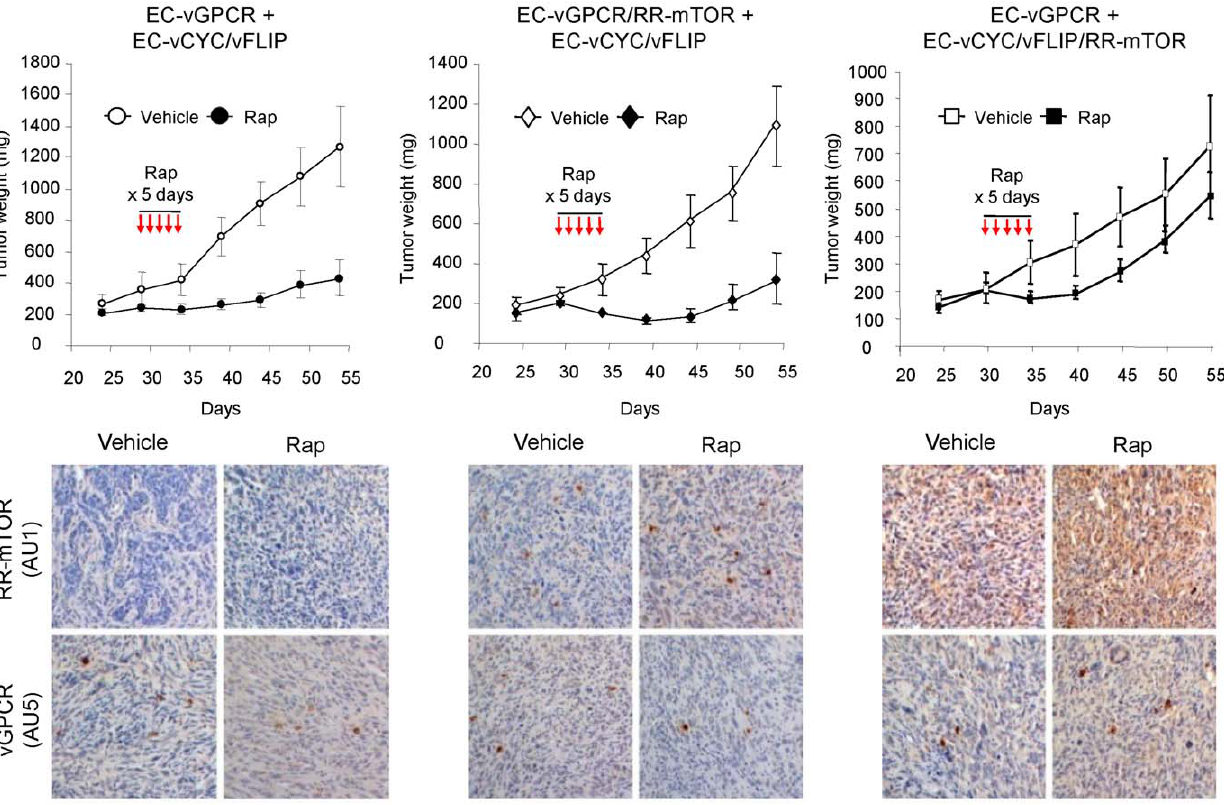
Figure 4. Paracrine activation of mTOR is required for vGPCR sarcomagenesis invivo . Tumor allografts were generated upon injection of athymic nu/nu mice with EC-vGPCR (10%) + EC-vCYC/vFLIP (90%) cells, EC-vGPCR/RR-mTOR (10%) + EC-vCYC/vFLIP (90%) cells or EC-vGPCR (10%) + EC-vCYC/vFLIP/RR-mTOR (90%) cells. Lesions were then treated with (10 mg/kg) Rapamycin or vehicle. Curves of tumor growth and immunohistochemical staining of tumor tissue with anti-AU1 or anti-AU5 antibodies, revealing expression of RR-mTOR or vGPCR, respectively, are shown.